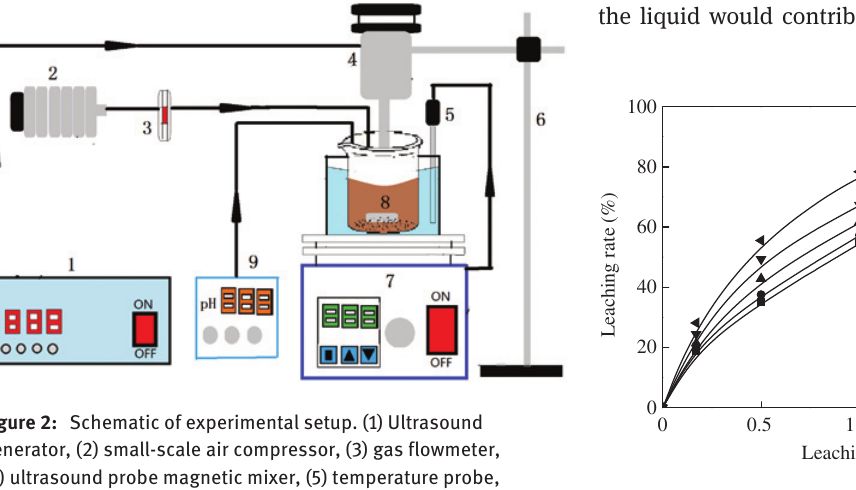
Figure 3: Effect of particle size on silver leaching